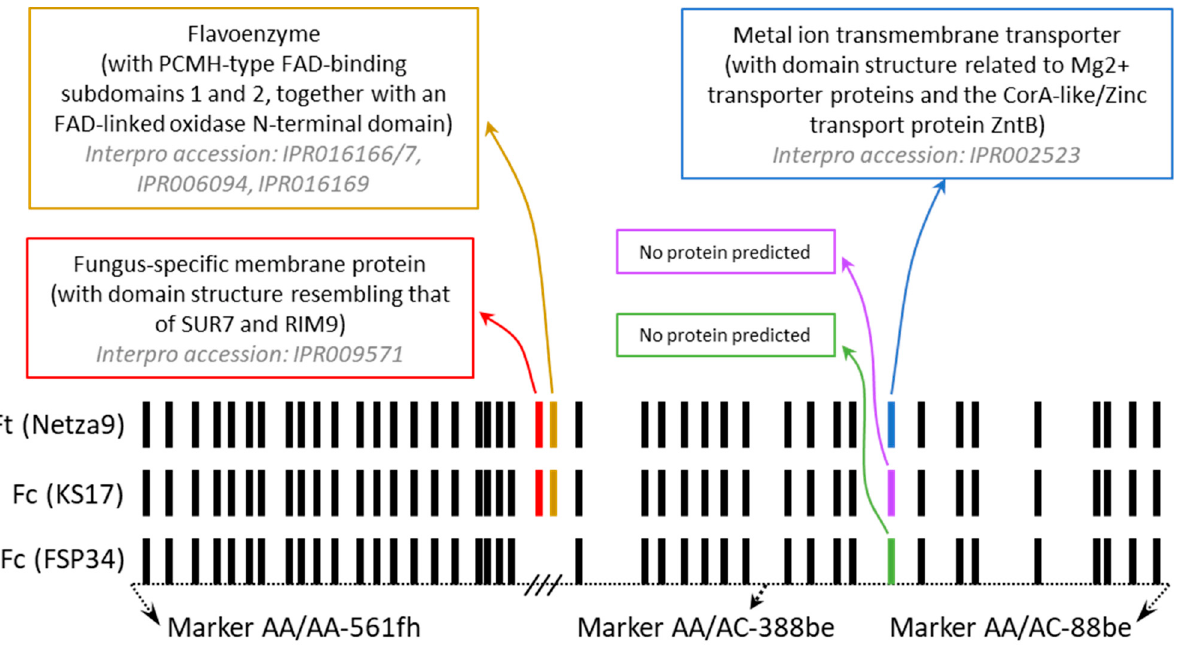
Figure 4. Schematic diagram of the organization of genes in the QTL region identified in the genomes of F. circinatum and F. temperatum . The two F. circinatum strains are indicated with Fc (FSP34) and Fc (KS17), while F. temperatum is indicated with Ft (Netza9). The black blocks represent the genes found to encode the same proteins in all three genomes. Colored blocks indicate non-homologous genes in the three genomes, where red indicates genes g13407 of F. temperatum and g13263 of F. circinatum KS17 and brown shows g13408 of F. temperatum and g13264 of F. circinatum KS17. Green, blue and purple, respectively indicate g13376 in F. circinatum FSP34, g13420 in F. temperatum , and g13276 in F. circinatum KS17. The three dashed lines indicate that the exact size of the region lacking the two genes in F. circinatum FSP34 is not known due to the presence of large retrotransposon Derivative (LARD) transposable elements.